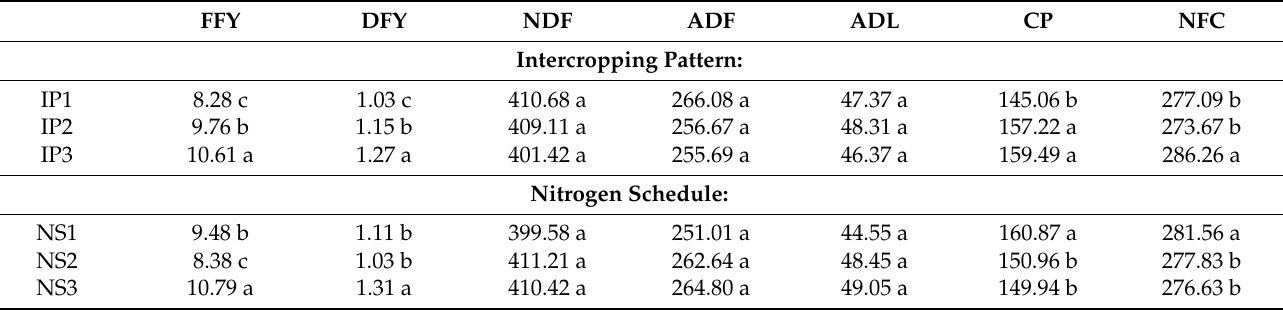
Table 5. Variations of the 1st cut fresh and dry forage yields (t ha − 1 ), neutral detergent fiber (NDF), acid detergent fiber (ADF) and acid detergent lignin (ADL), crude protein (CP), and non-fiber carbohydrates (NFC) contents (g kg − 1 ) of forage cowpea as affected by the intercropping pattern and nitrogen schedule combined over the two growing